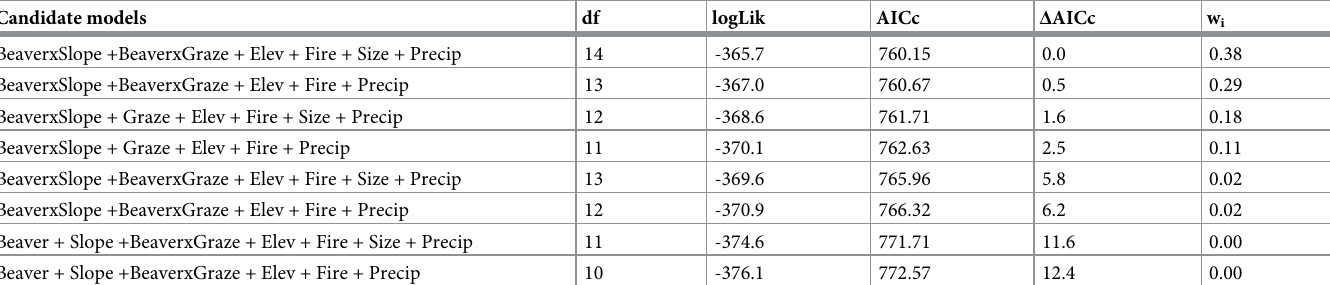
Table 3. Candidate models explaining how spatial covariates influence riparian vegetation productivity (NDVI). Candidate